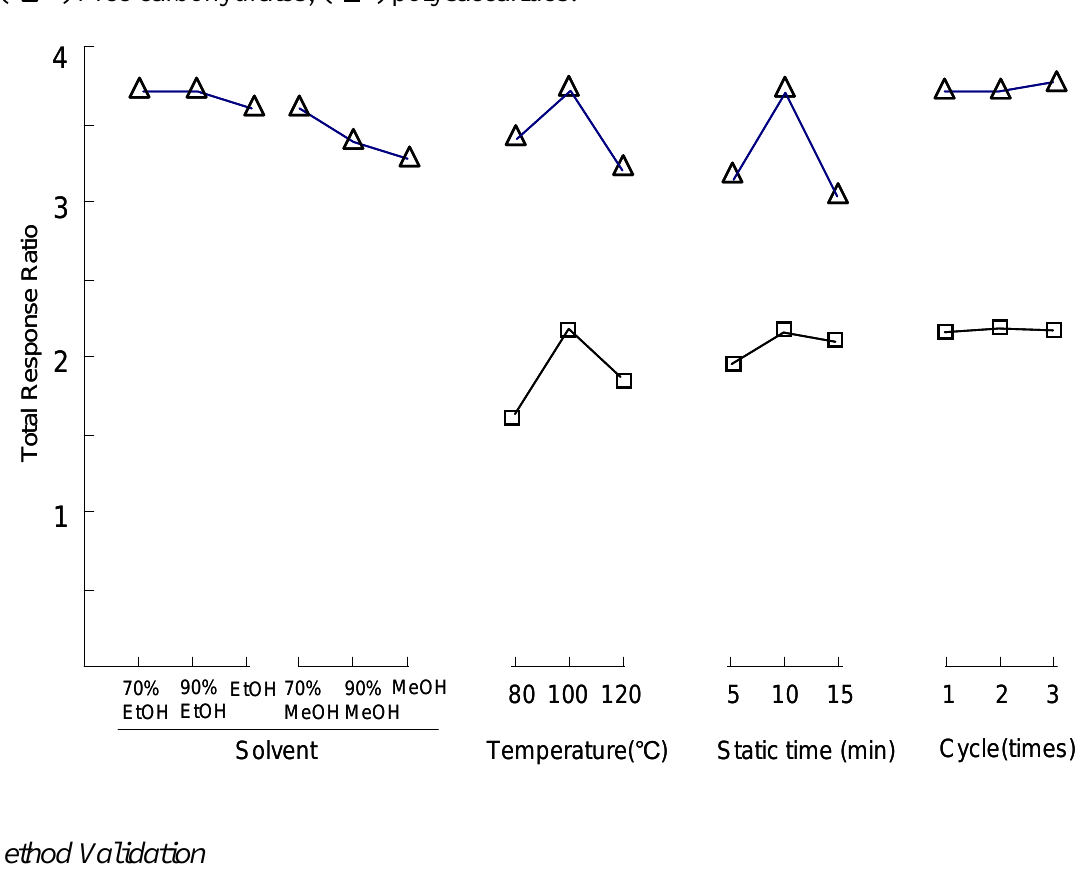
Figure 3. Optimization of pressurized liquid extraction of carbohydrates in Cordyceps